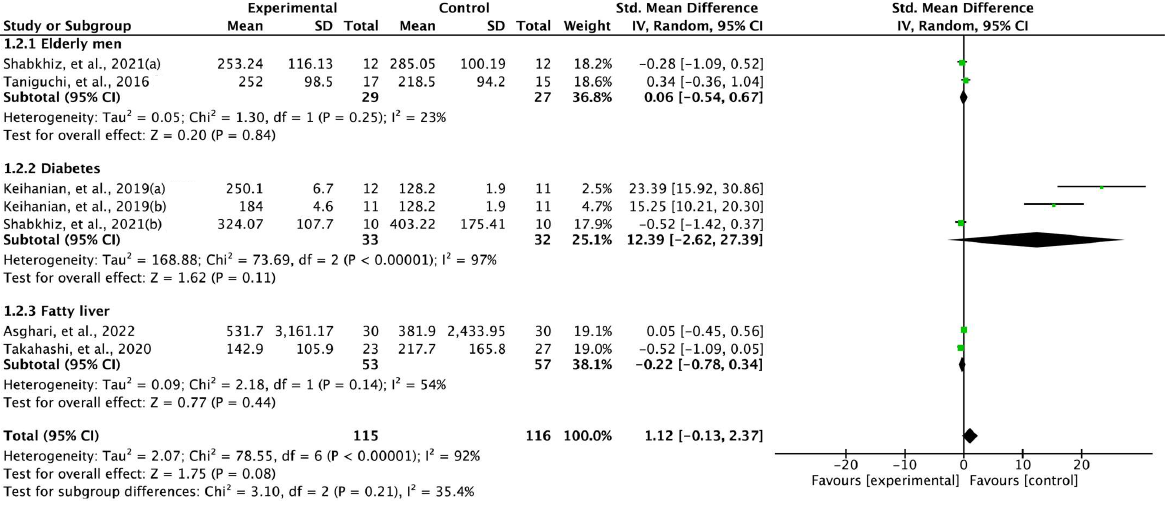
Figure 4. Forest plot of between-group comparisons, i.e., intervention and control groups, of changes in exercise-induced fibroblast growth factor-21 levels [29,30,31,33,35]. Keihanian, et al., 2019(a) [29]—resistance exercise; Keihanian et al., 2019(b) [29]—aerobic exercise; Shabkhiz, et al., 2021(a) [30]—without type 2 diabetes; Shabkhiz et al., 2021(b) [30]—with type 2 diabetes.